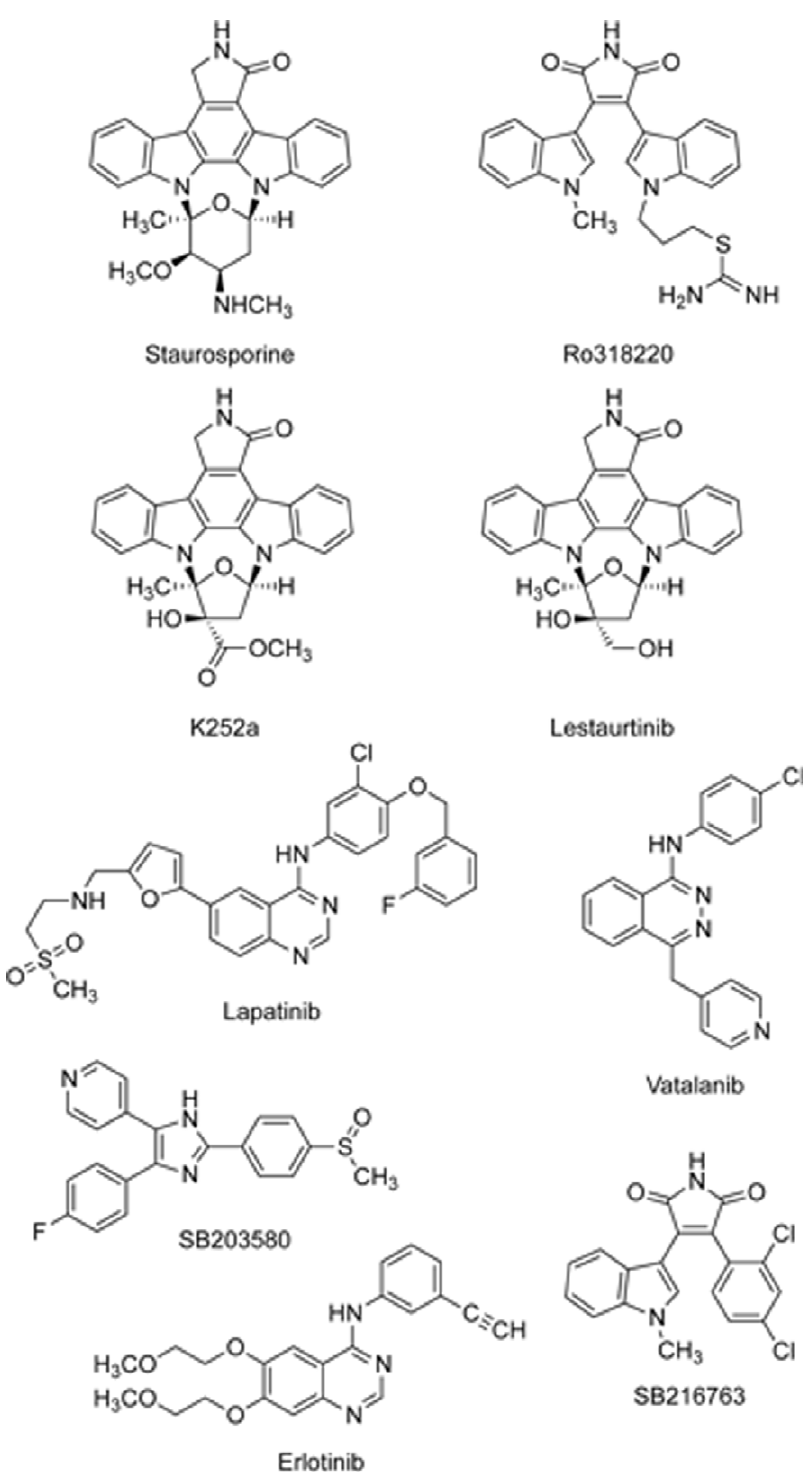
Figure 1. Known and newly identified PRK1 inhibitors.